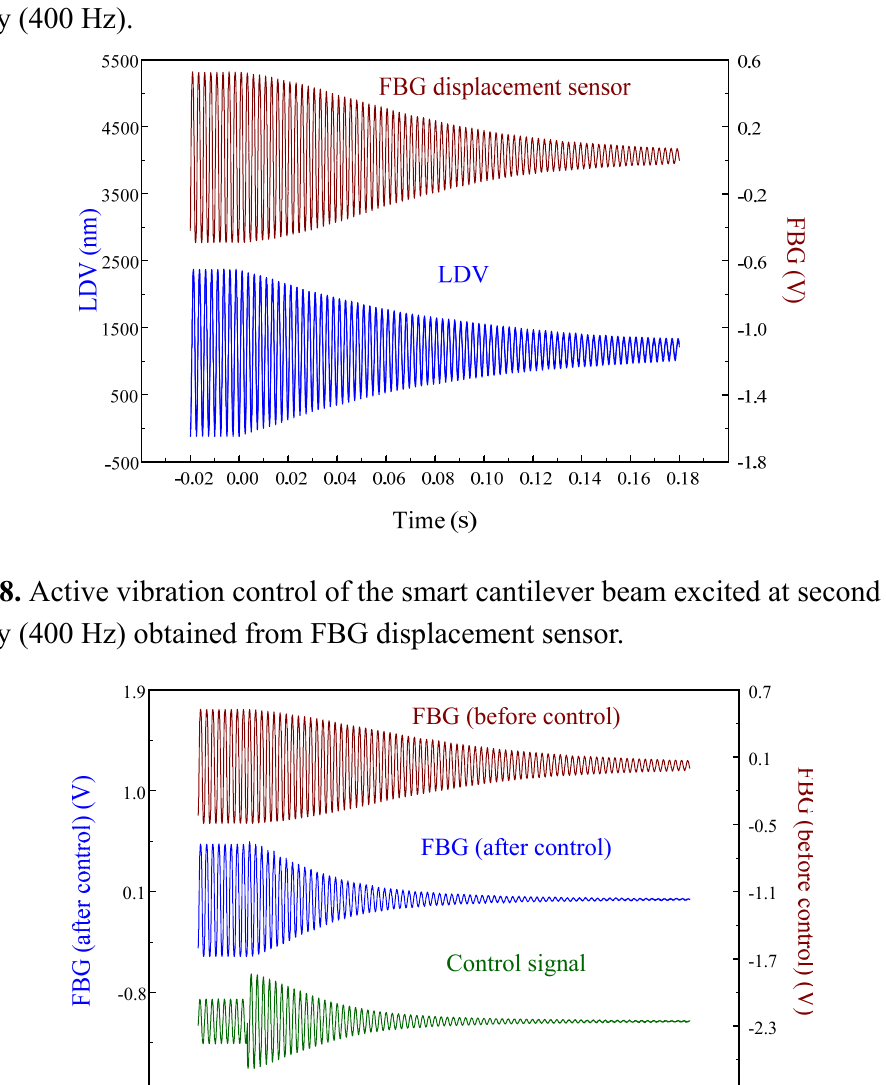
Figure 27. Free vibration of the smart cantilever beam excited at second resonant frequency (400 Hz).